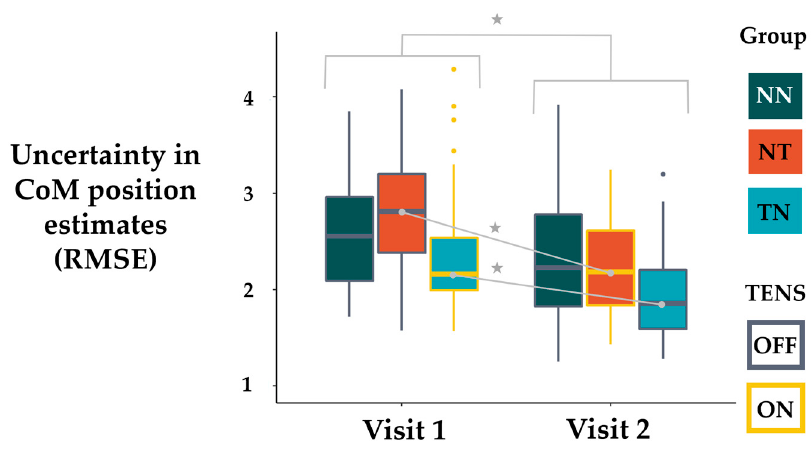
Figure 3. The response uncertainty for the three groups across visits. The groups that received TENS significantly decreased their response uncertainty from visit 1 to visit 2. ★ = p value < 0.001.